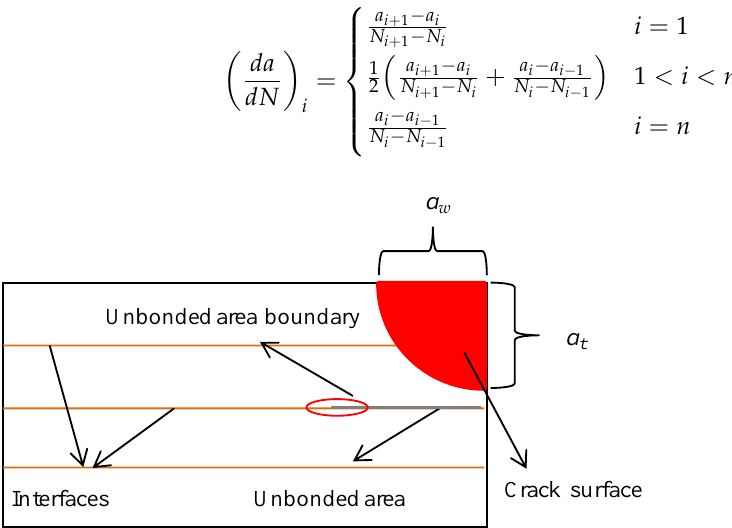
Figure 8. Section diagram of unbonded titanium alloy laminate.